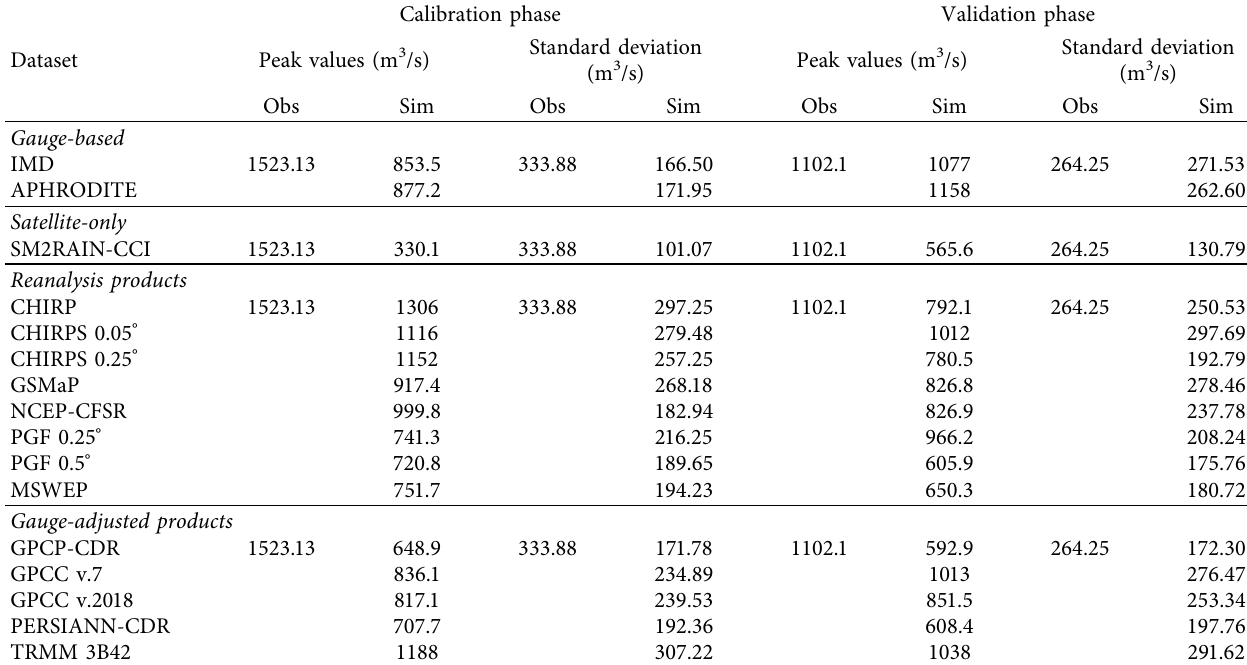
Table 5: Streamflow characteristics during calibration and validation phases (Obs: observed; Sim: simulated).